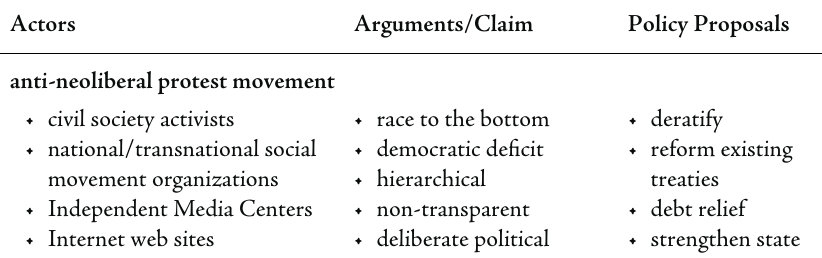
Figure 1 – Contested Interpretations of Globalization